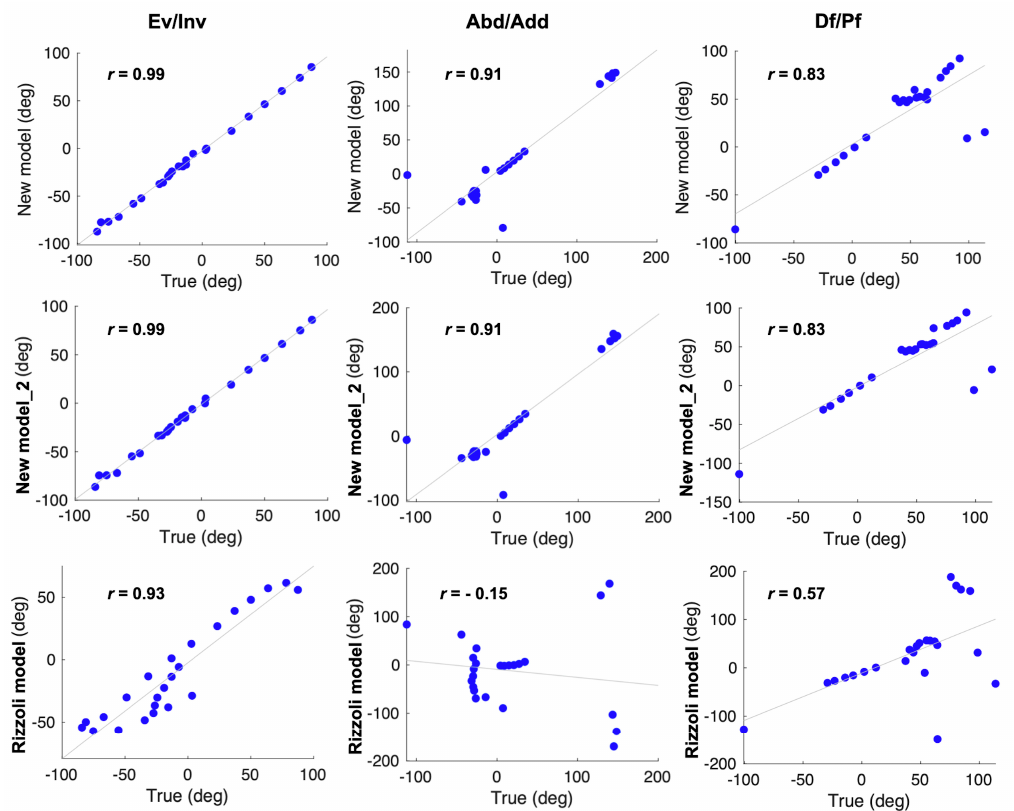
Figure 6. Univariate analysis using Pearson’s correlation analysis. Left to right, the Cal_Met angle in the frontal, transverse, and sagittal planes are shown. Correlations were assessed between the true values and the calculated values according to the three models, respectively; our new model (first row), our new model_2 (second row), and the Rizzoli model (third row).